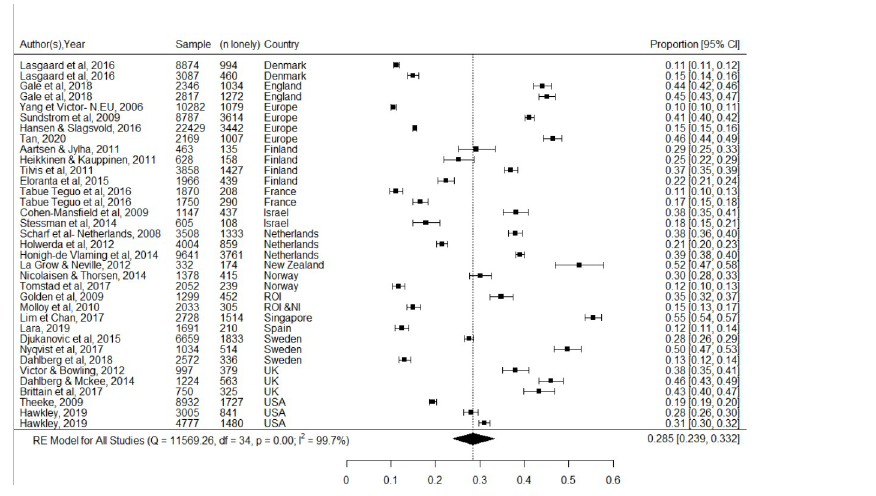
Fig 3. Forest plot of loneliness prevalence estimates from 31 included